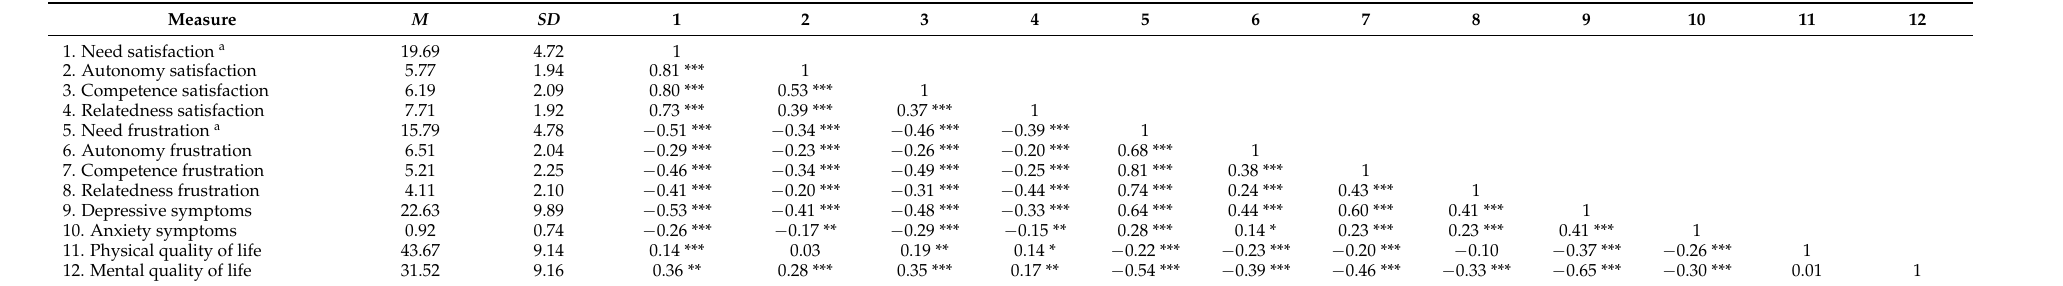
Table 1. Means, standard deviations, and correlations among the main study